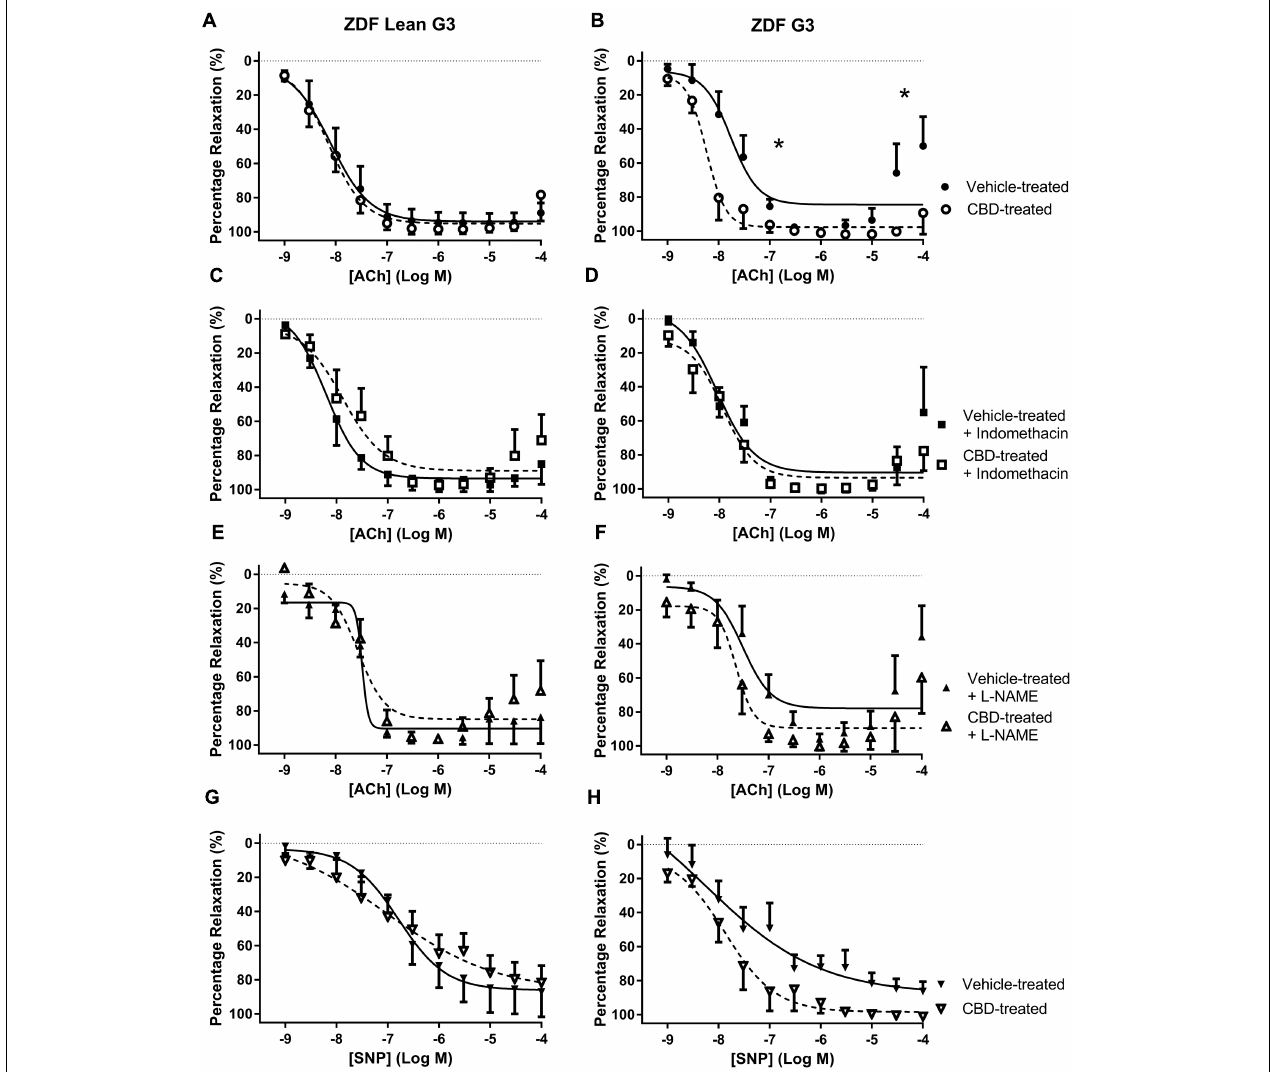
FIGURE 2 | The effect of CBD (open symbols) or vehicle (closed symbols) treatment on ex vivo responses to ACh (A–F) and SNP (G,H) in rings of third-order mesenteric arteries taken from ZDF Lean (left side) or ZDF rats (right side). Some arteries were incubated in vitro in the presence of 3 µ M indomethacin (squares, C,D ), or 300 µ M L-NAME (upward triangles, E,F ). Data are mean ± SEM, n = 5/6. ∗ P < 0.05 comparing the potency (EC 50 ) and efficacy ( R max ) of Ach in ZDF arteries after 7 days CBD